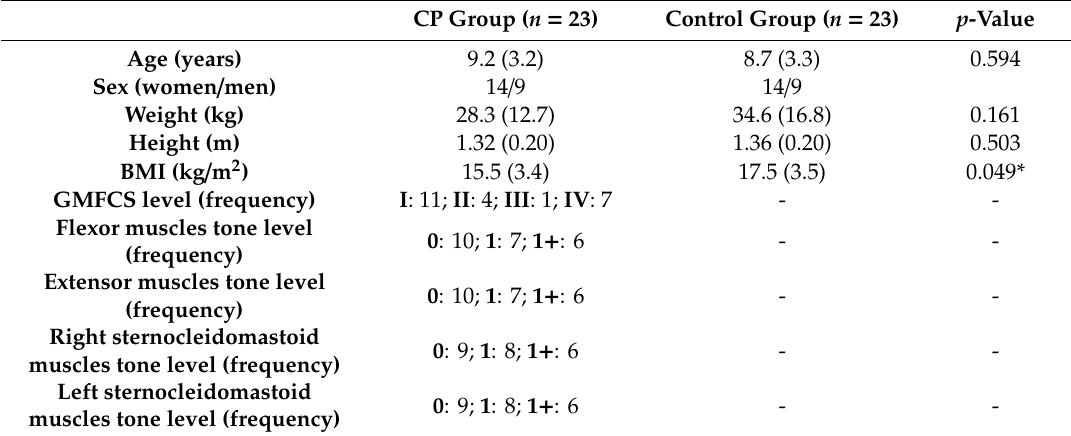
Table 1. Demographics and clinical characteristics of the subjects.